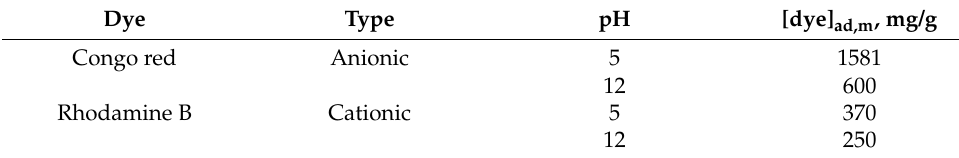
Table 7. Influence of the pH on the adsorption of anionic and cationic dyes. Dye